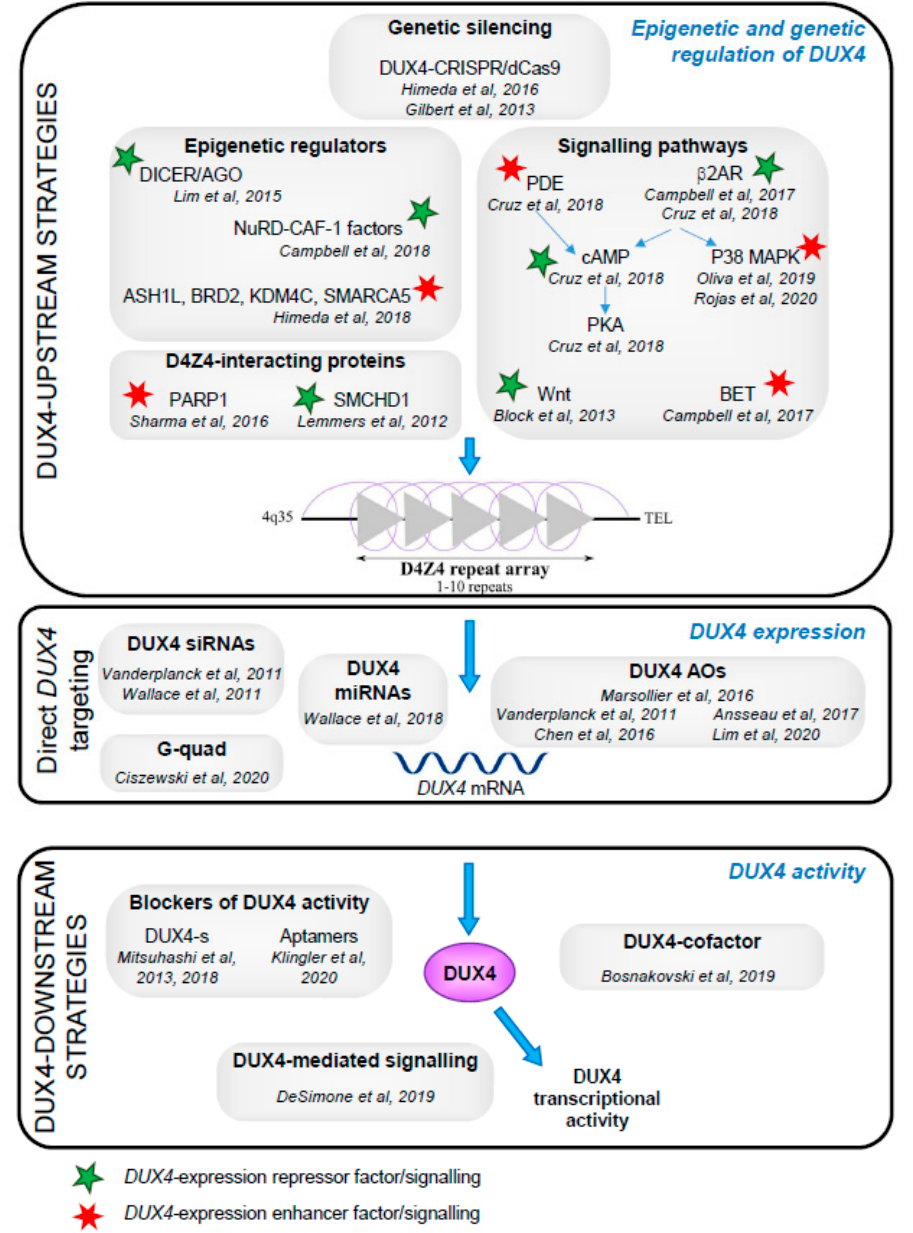
Figure 1. Graphical summary of therapeutic strategies targeting DUX4 in facioscapulohumeral muscular dystrophy (FSHD). Diagram summarizing the different therapeutic strategies discussed in this review. Targeting DUX4-mediated toxicity in skeletal muscle was achieved by 1) genetically or epigenetically regulating DUX4 expression, 2) directly targeting DUX4 transcript by RNAi or AOs-based approaches, and 3) inhibiting DUX4 activity. Numerous studies have tried to identify proteins and signaling pathways involved in regulating DUX4 expression (top section of the diagram). These factors had either positive or negative effects on gene expression. The green star represents DUX4-repressors while the red star corresponds to enhancers of DUX4 expression. The characteristic chromatin relaxation is illustrated in light purple and the D4Z4 hypomethylation status is depicted by the light grey triangles.